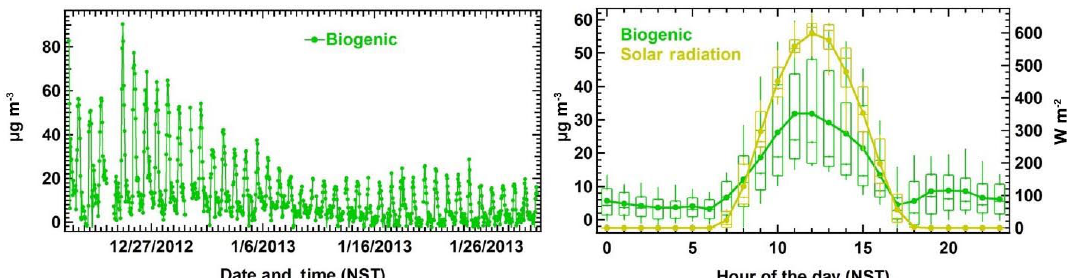
Figure 11. Time series and diel box and whisker plot for Factor 8 (biogenic